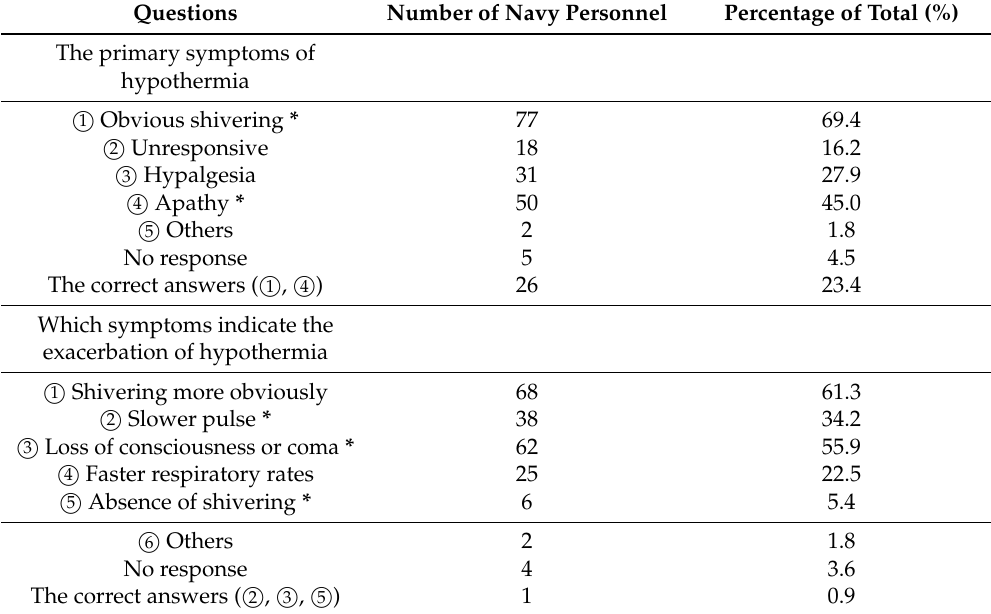
Table 2. Choice of symptoms ( n = 111).